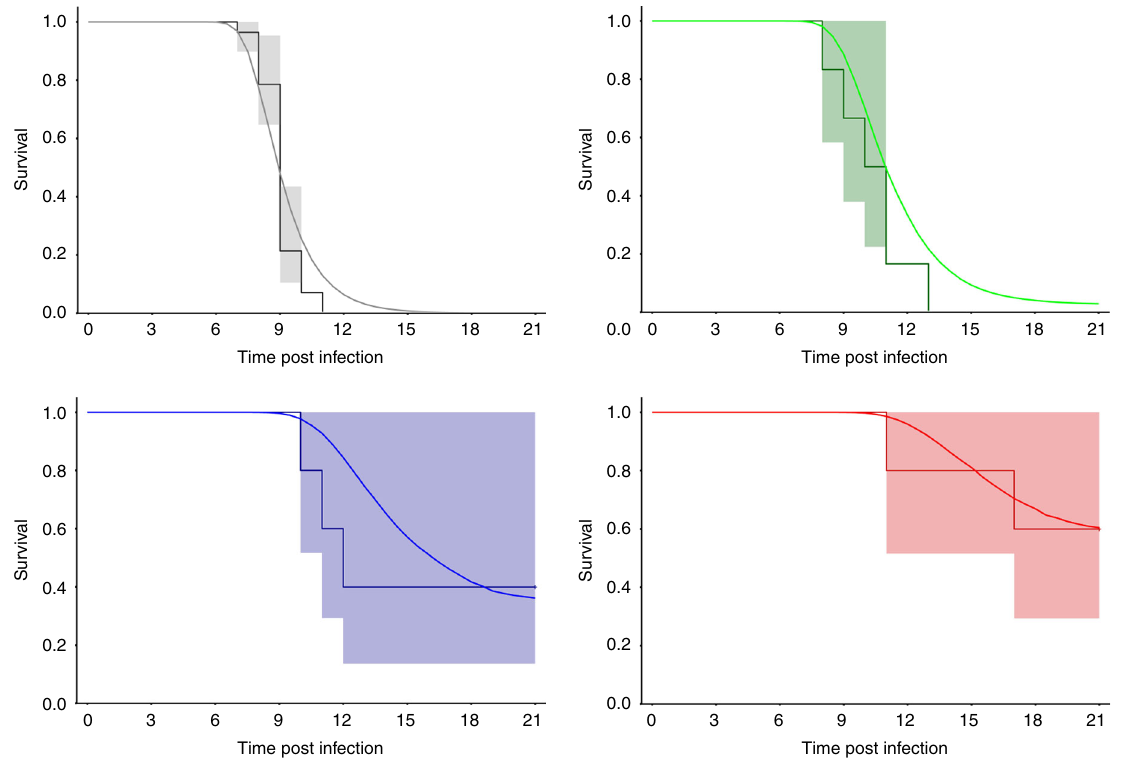
Fig. 4 Model-based predicted survival rate (plain lines) and Kaplan – Meier survival curves and 95% con fi dence interval (shaded areas) for each dosing regimen group. Top left: cynomolgus experiment control pooled from the 4 experiments ( N = 28), top right: favipiravir 100 mg kg − 1 BID ( N = 6), bottom left: favipiravir 150 mg kg − 1 BID ( N = 5), bottom right: favipiravir 180 mg kg − 1 BID ( N = 5). In each panel, model-based predicted survival rate was calculated by simulating 1000 individuals for each dosing regimen and taking the medians of the predicted individual survival functions at each